Question: Provide a one-line summary of what is displayed.
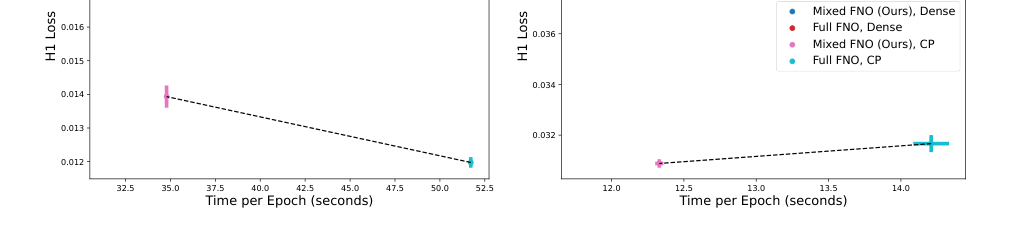
Answer: For Navier-Stokes (Left) and Darcy Flow (Right), our method accelerates training, whether with CP factorized weights or Dense unfactorized weights, without losing more than 1% in error.